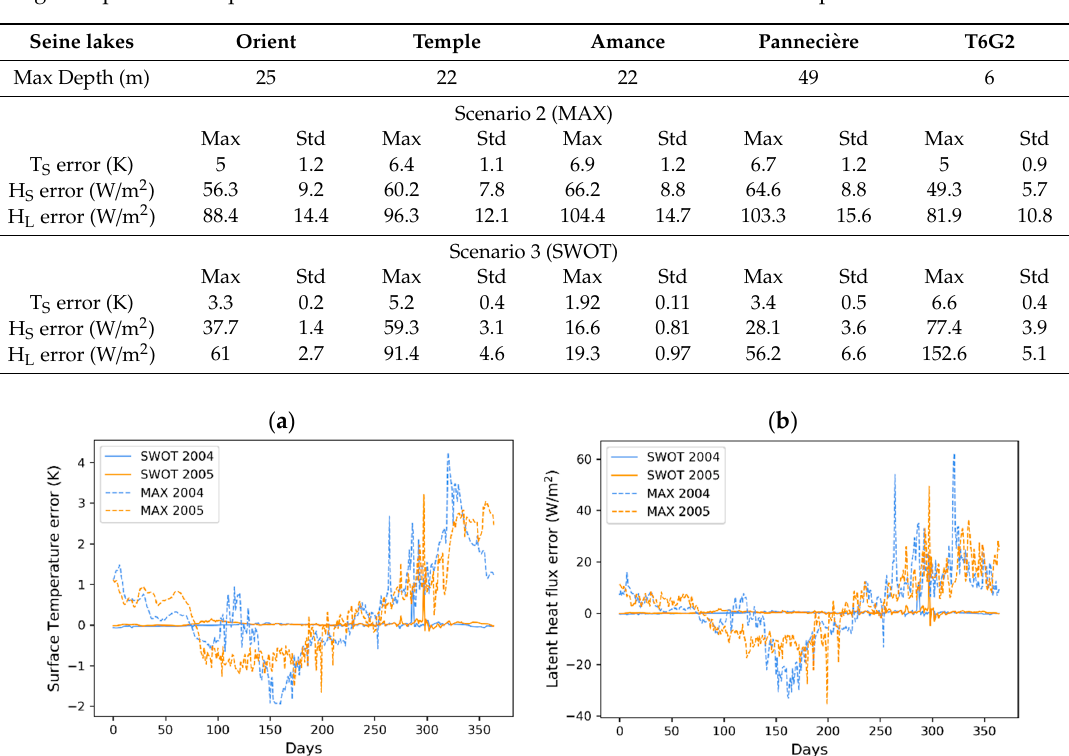
Table 4. Standard (Std) and maximum (max) errors on FLake surface temperature (in K) and surface heat fluxes (in W / m 2 ), calculated over a five-year period, for the four reservoirs of the Seine and T6G2 gravel pit. The comparison is done for the MAX and SWOT simulations in comparison to REF.